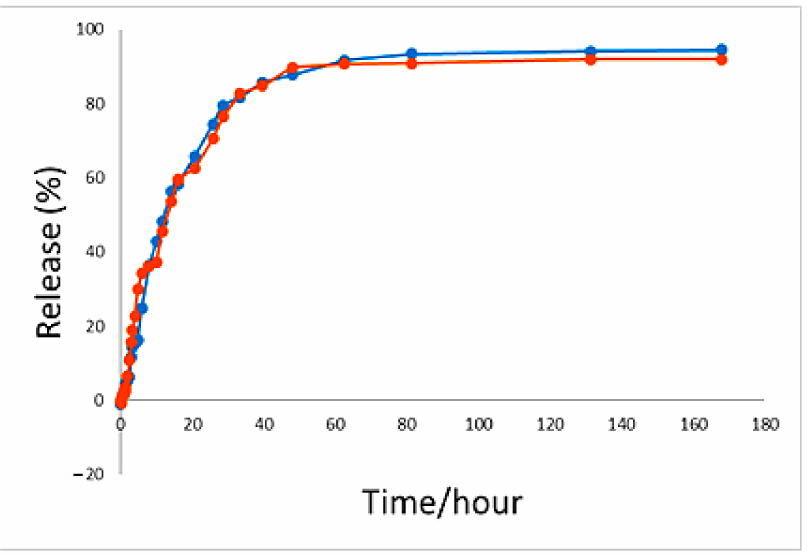
Figure 8. The 5-fluorouracil release profiles from FPVAFU-ZLDH in phosphate-buffered solutions at pH 4.8 and pH